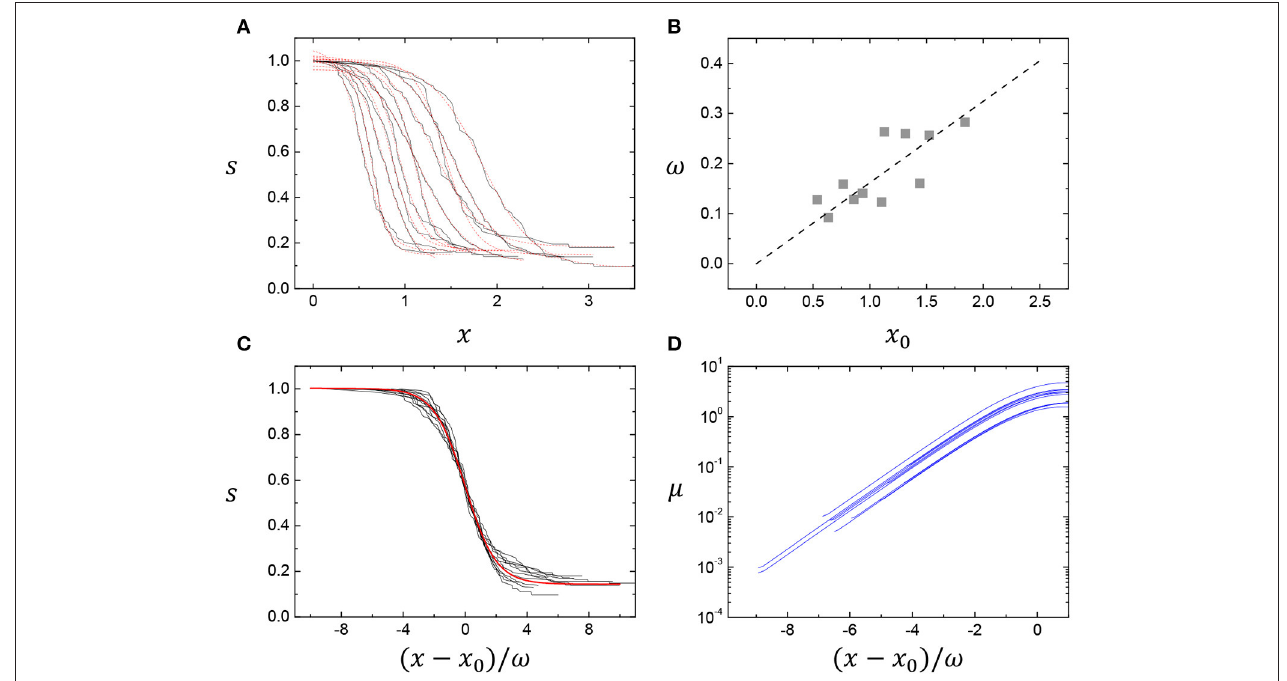
FIGURE 2 | Sigmoidal and demographic analyses of bubble coalescence events in clean foams. (A) The normalized current number of bubbles with the rescaled time [from the Dataset 1 , reproduced by Dr. Peter Stewart (personal communication) (solid lines), identical to Figure 1B ] agrees well the Boltzmann sigmoidal function (dashed lines, see details on data collection and analysis in the Supplementary Note ). (B) In the Boltzmann sigmoidal fits, two parameters, x 0 and ω , have a linear proportion. (C) A master survival curve (solid red line) is achieved. (D) The death (mortality) curves, µ , are calculated from the fitted survival curves. This result clearly shows that the death rates in clean foams increase exponentially with age, consistent with the Gompertz mortality law, regardless of the initial